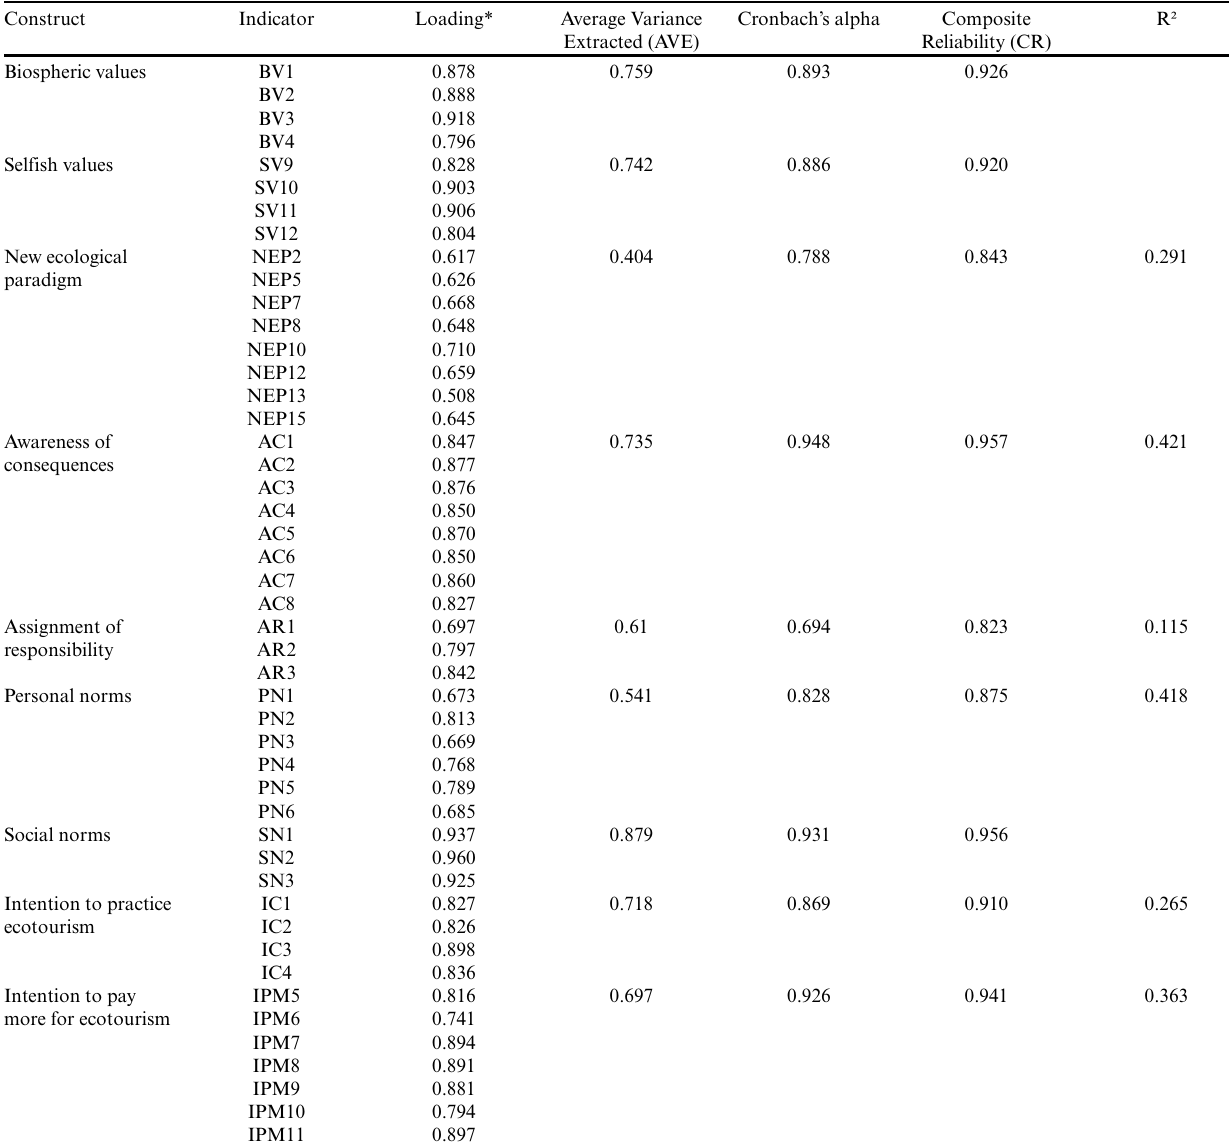
Table 3 . Internal consistency and convergent